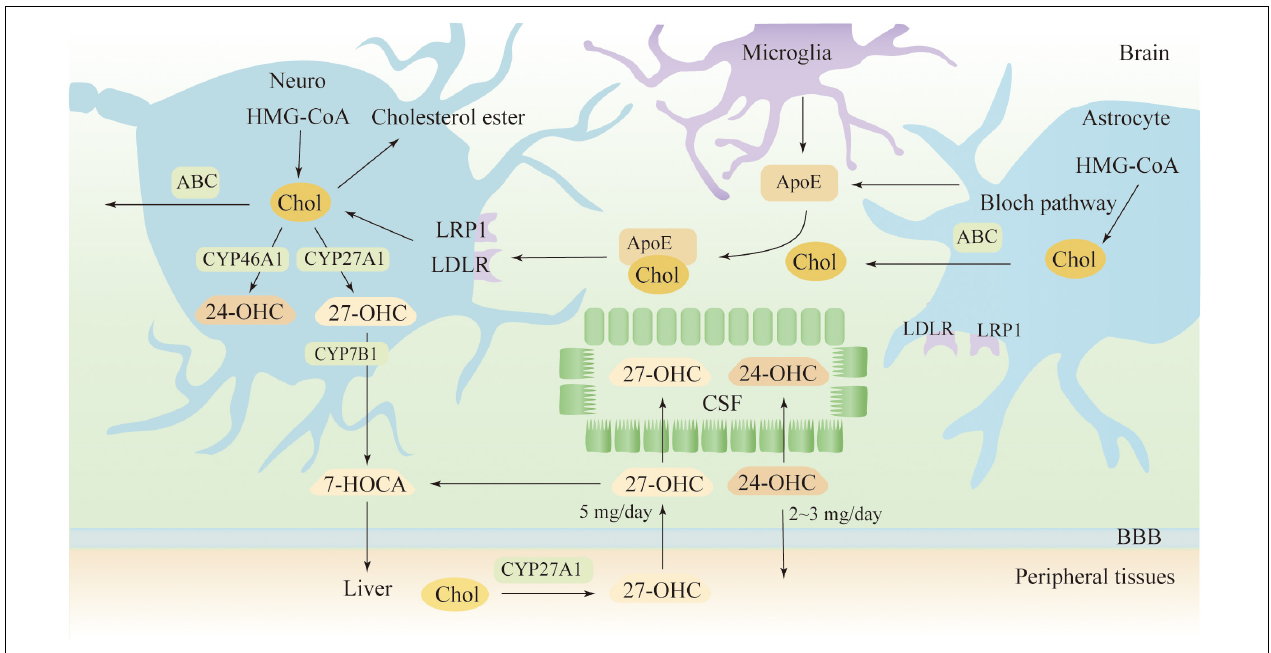
FIGURE 1 | Cholesterol metabolism in the brain. 7-HOCA, 7 α -hydroxy-3-oxo-4-cholestenoic acid; 24-OHC, 24(S)-hydroxycholesterol; 27-OHC, 27-hydroxycholesterol; ABC, ATP-binding cassette; ApoE, apolipoprotein E; Chol, cholesterol; CSF, cerebrospinal fluid; LDLR, low-density lipoprotein receptor; and LRP1, LDL receptor-like protein 1.